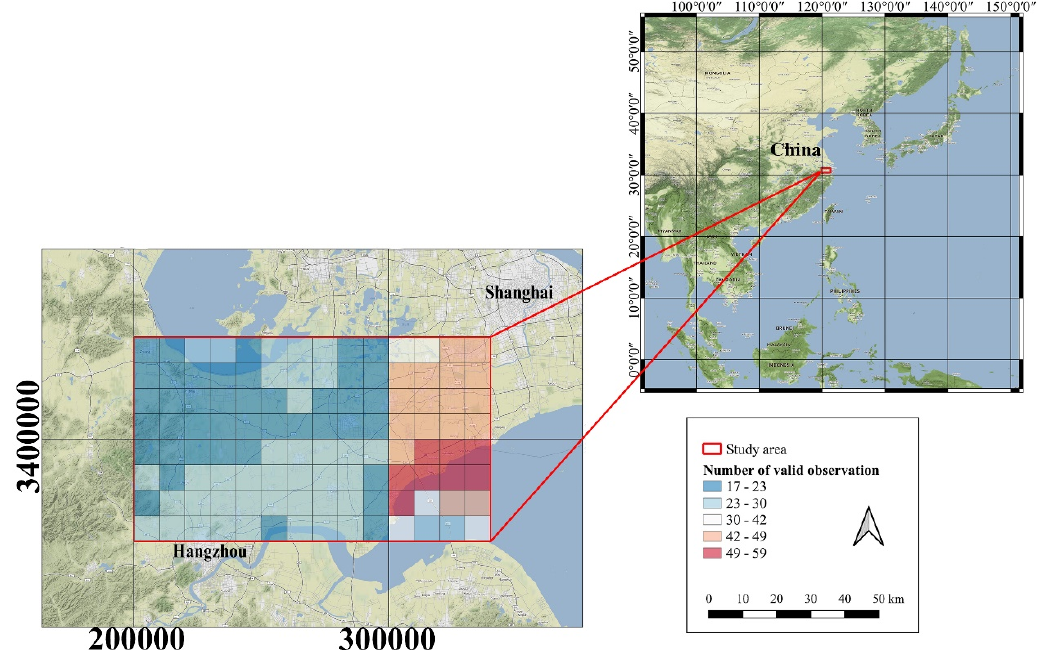
Figure 1. The lower-left map indicates the location of the study area in a coordinate reference system of WGS 84 UTM zone 51, overlaid with the Military Grid Reference System (MGRS) 10-km grids, the colors of which indicate the number of clear images with cloud pixel percentage less than 5% from Sentinel-2 in 2019.